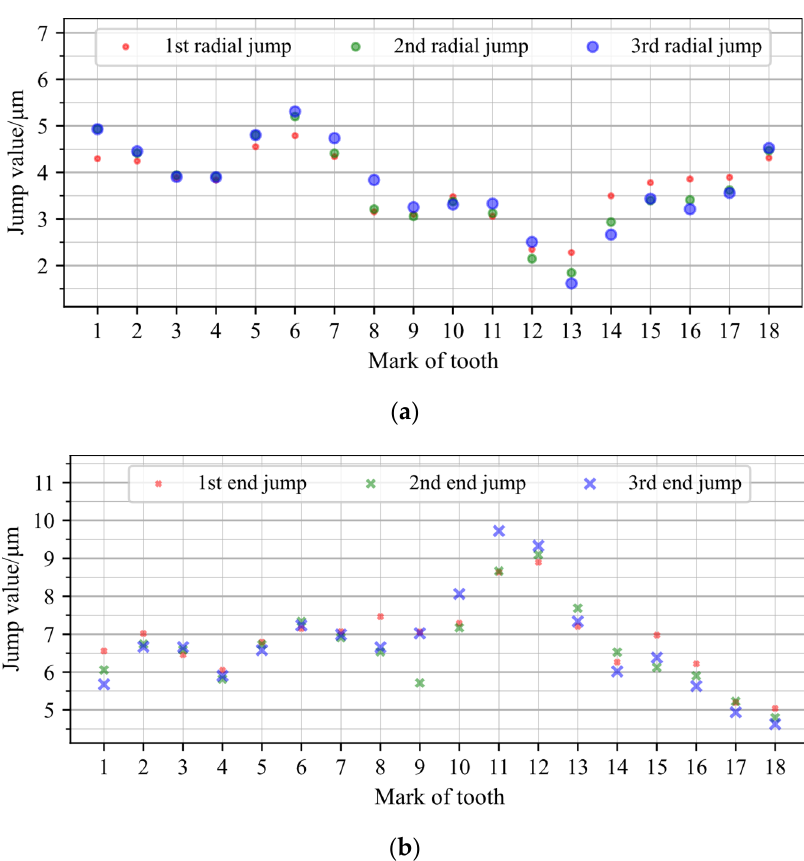
Figure 13. Test results of experimental group 1 after tooth rotation. ( a ) Radial jump; ( b ) end jump.